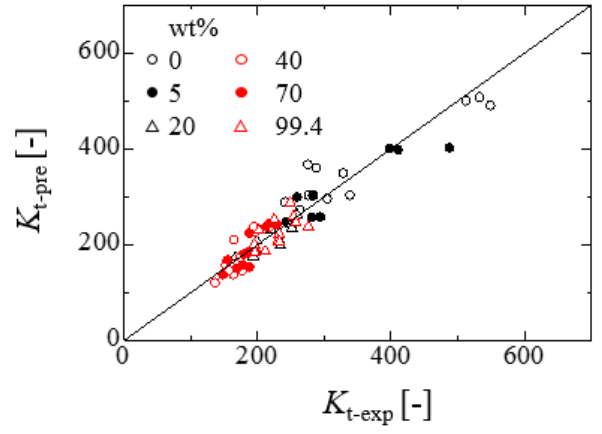
Figure 11. Comparison of K t-exp with K t-pre in each liquid.